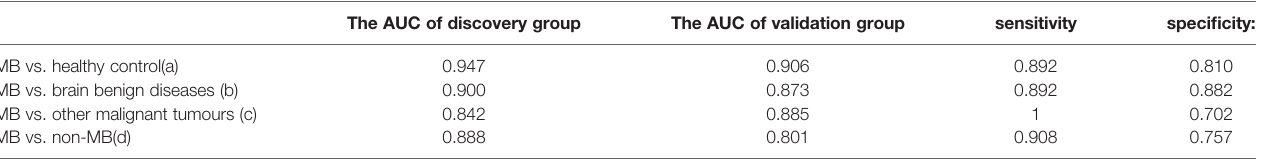
TABLE 2 | AUC values of panels for MB and other groups distinction on urine metabolomics. The AUC of discovery group The AUC of validation